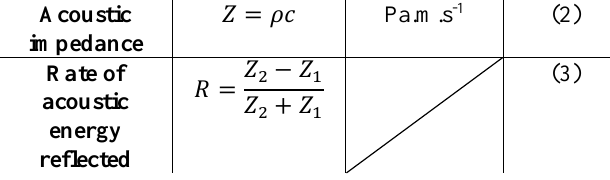
Table 3 : Definition of acoustic impedance and Rate of reflected energy